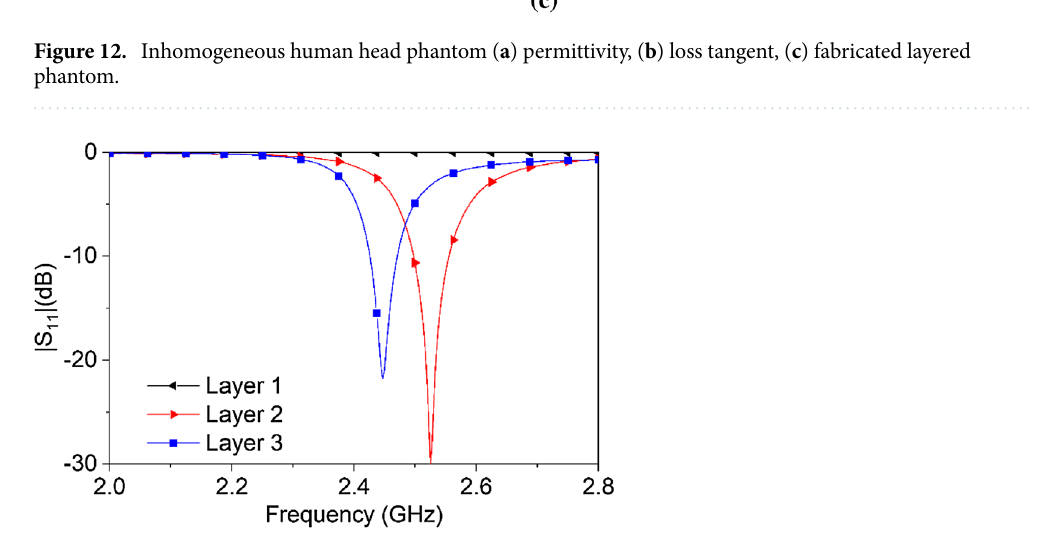
Figure 13. Reflection coefficient of the feeding antenna for addition of different layers on the